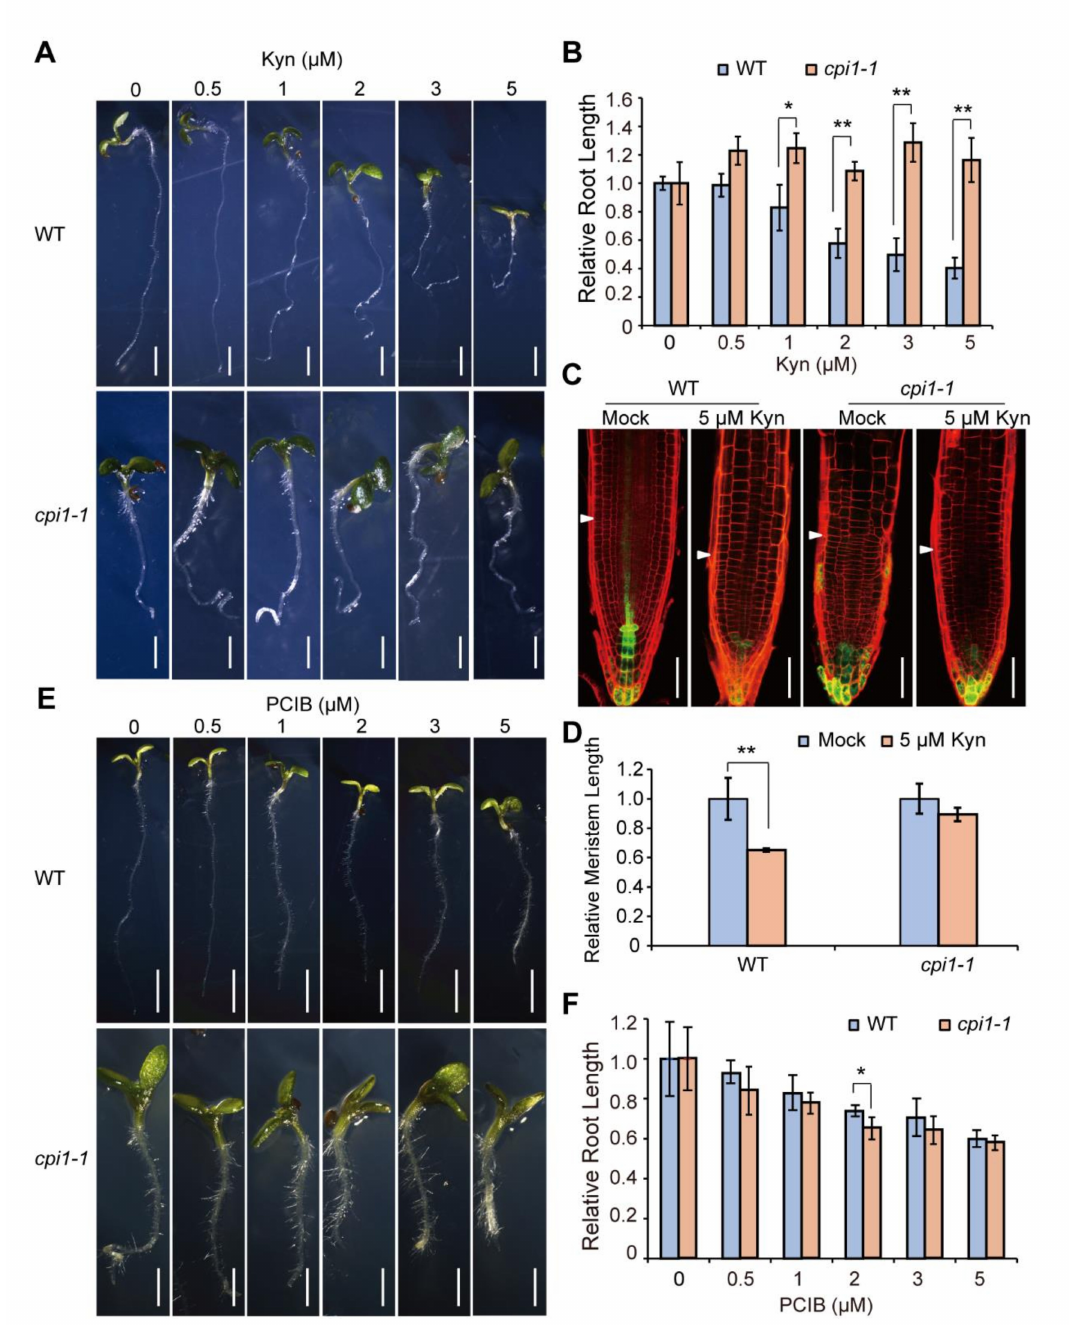
Figure 4. The cpi1-1 short root phenotype is partially rescued by the L-Kynurenine (Kyn) auxin biosynthesis inhibitor, while cpi1-1 responds normally to the p -Chlorophenoxyisobutyric acid (PCIB) auxin signaling inhibitor. ( A , E ) Phenotypes of WT and cpi1-1 seedlings after treatment with various concentrations of Kyn ( A ) and PCIB ( E ) for 7 days; ( B , F ) Relative root length of 7-day-old WT and cpi1-1 seedlings grown on MS medium supplemented with different concentrations of Kyn ( B ) and PCIB ( F ). MS medium supplemented with 0.1 mM HCl and 0.1% ( v / v ) ethanol, solvent for Kyn and PCIB, respectively, served as blank controls. The presented data are means ± SD of n = 3 independent experiments (employing 8 to 55 seedlings per experiment. * p < 0.05, ** p < 0.01 (one-way ANOVA with Tukey’s test); ( C ) Meristem architectures of 7-day-old WT and cpi1-1 seedling roots grown on MS medium supplemented with or without 5 µ M Kyn; ( D ) Relative meristem zone length of 7-day-old seedling roots. The presented data are means ± SD of n = 3 independent experiments (employing 18 to 28 roots per experiment). ** p < 0.01 (Student’s t -test, one-tailed, two-sample equal variance). Bars = 2 mm in ( A , E , top panel), 1 mm in ( A , E , bottom panel), and 50 µ m in ( C